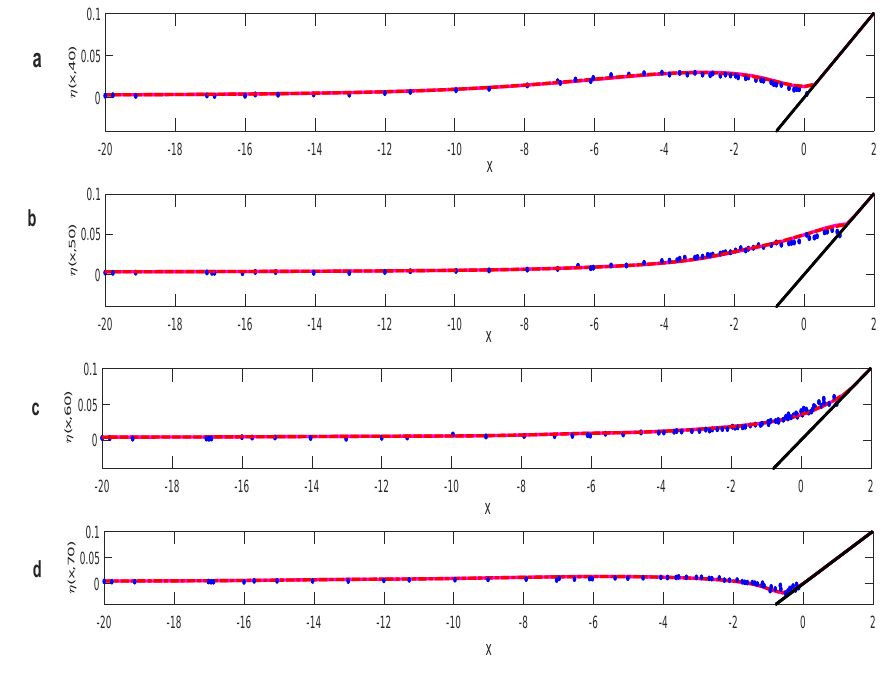
Figure 6. Wave surface profile for A / d 0 = 0.0185 at ( a ) t = 40, ( b ) t = 50, ( c ) t = 60, ( d ) t = 70. Experimental data (.), hydrostatic model (- -), and non-hydrostatic model (-).